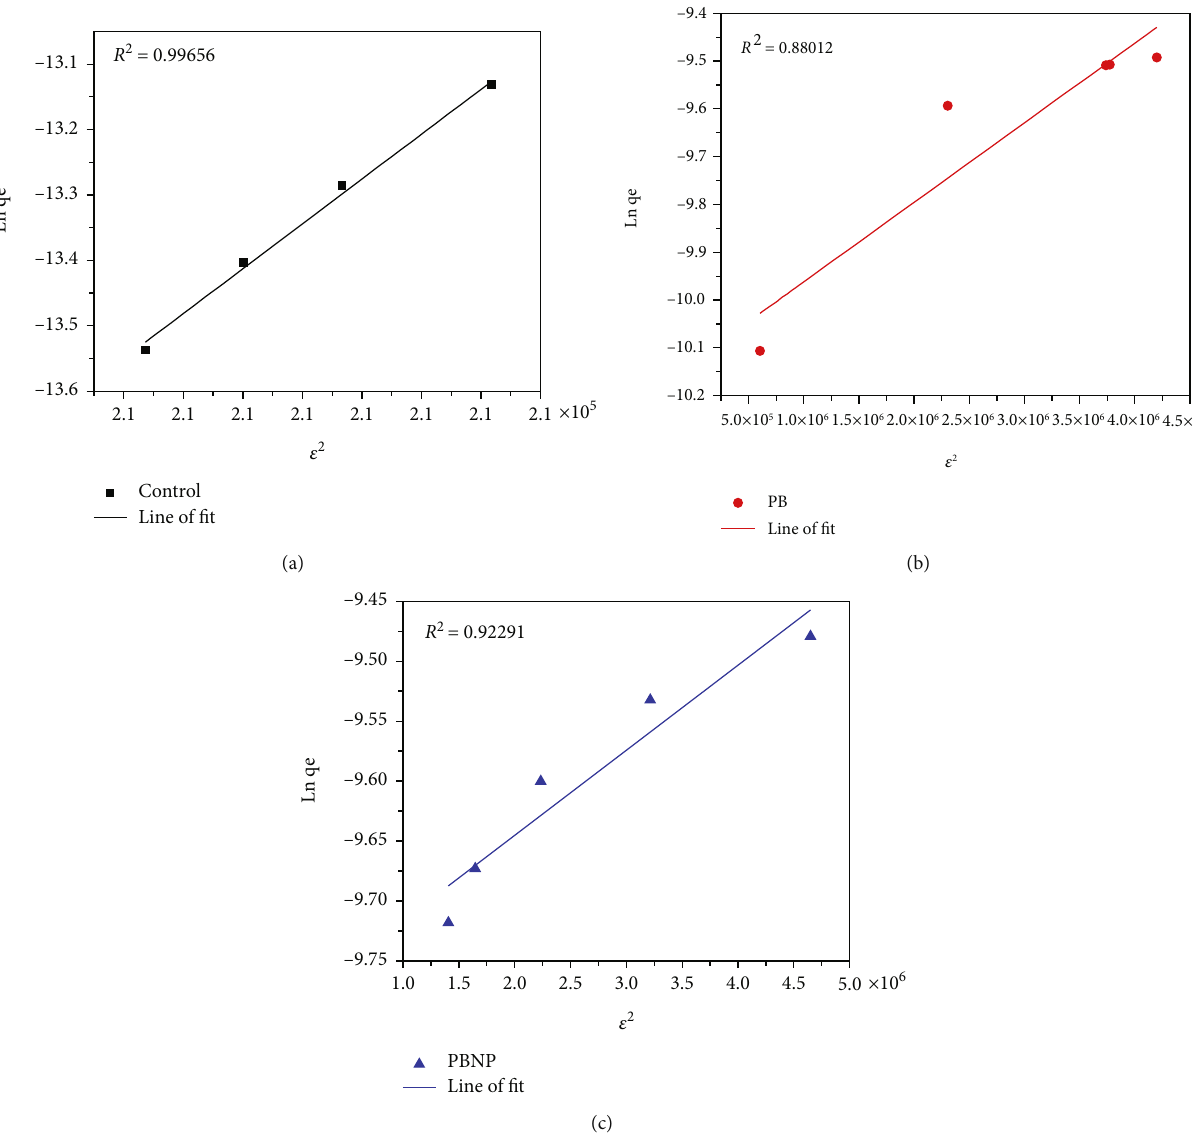
Figure 7: The Dubinin-Radushkevich isotherm plot of control (a), PB (b), and PBNP (c)